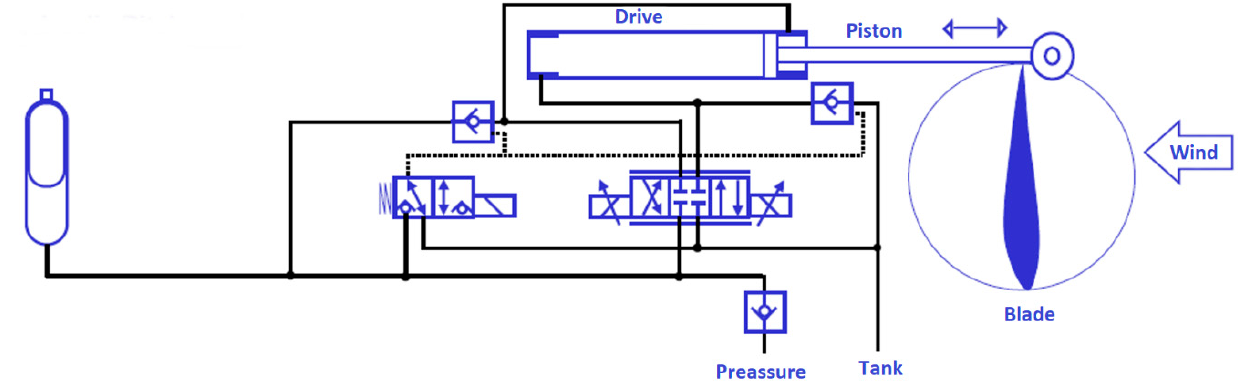
Figure 4. Principle of operation of the hydraulic blade rotation system [24] .